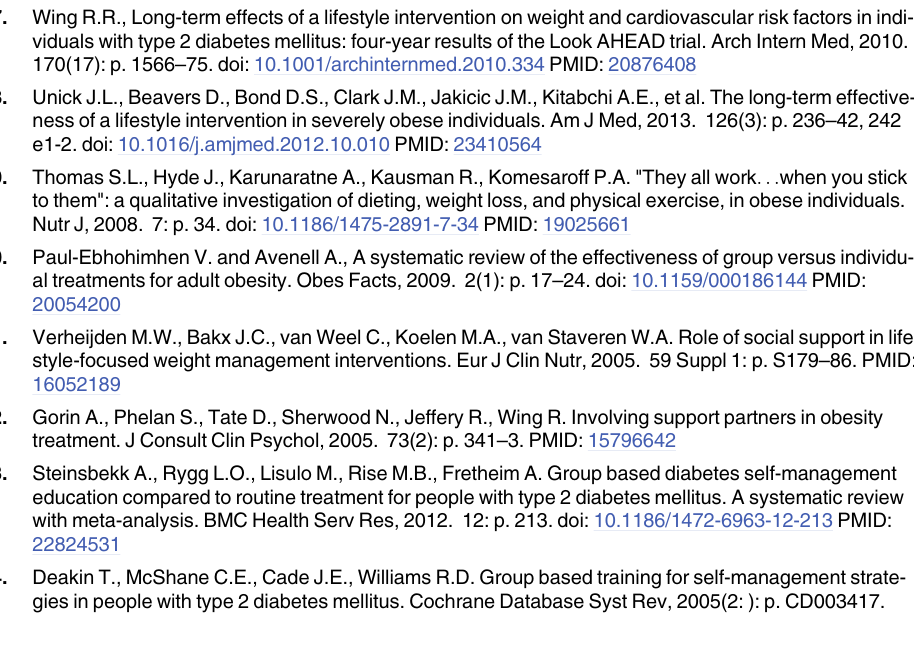
PLOS ONE | DOI:10.1371/journal.pone.0129348 June 8,